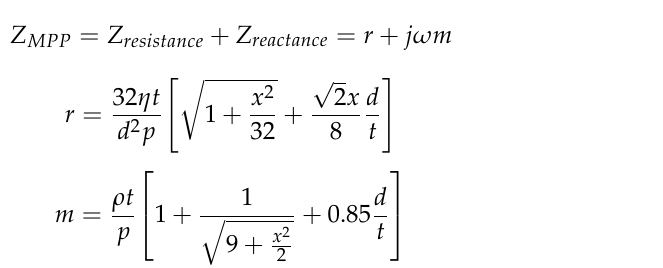
Figure 1. ( a ) An MPP and its geometrical parameter and ( b ) its equivalent circuit. The acoustic impedance of the MPP ( Z MPP ) in Equation (1) is composed of a real part denoted as r (Equation (2)), constituting the resistive part of the panel, more specifically, the viscous losses at the edges. On the other hand, m (Equation (3)) is the imaginary part, corresponding to the reactance of the inertial motion of air in the small holes.